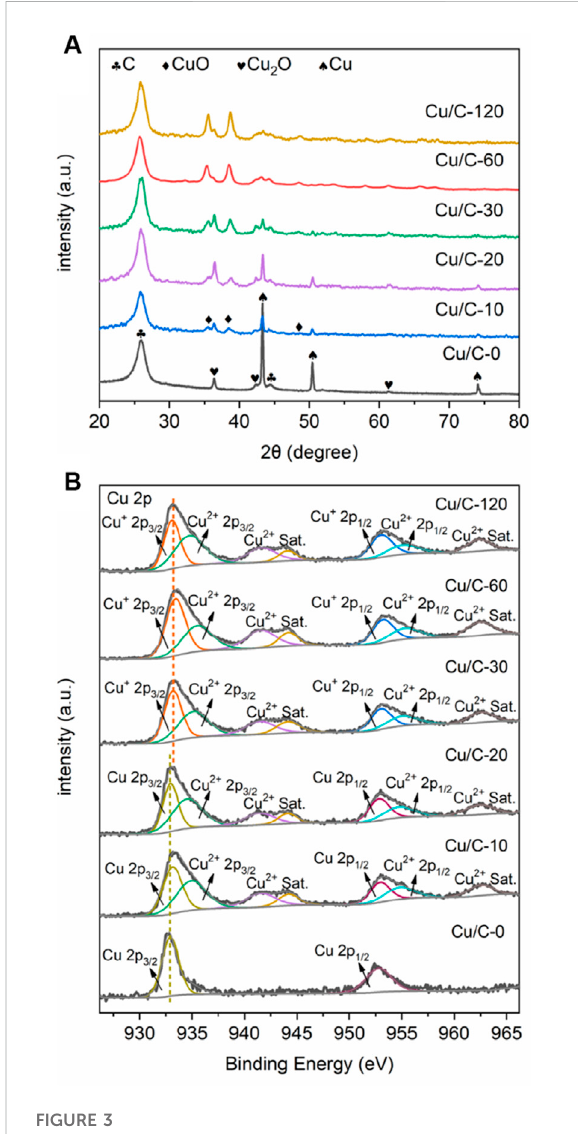
FIGURE 3 (A) XRD patterns and (B) Cu 2p XPS spectra for Cu/C-0, Cu/ C-10, Cu/C-20, Cu/C-30, Cu/C-60 and